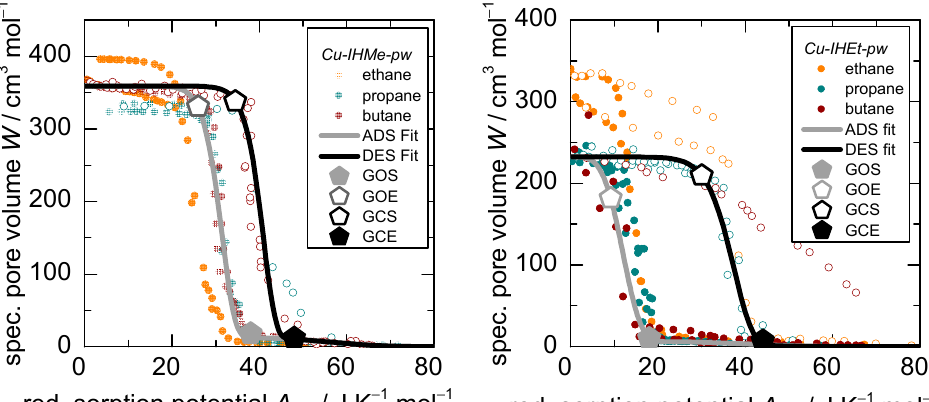
Figure 6. D-UAT plot with the reduced sorption potential A red for adsorption (filled circles) and desorption (empty circles) of C2 to C4 n -alkanes on the flexible Cu-IHMe-pw ( left ) and Cu-IHEt-pw ( right ). Furthermore, the respective fits of the dual Dubinin–Asthakov function are shown for both processes as well as the boundaries of the structural transition (GOS—gate opening start, GOE—gate-opening end, GCS—gate closing start, GCE—gate closing end).